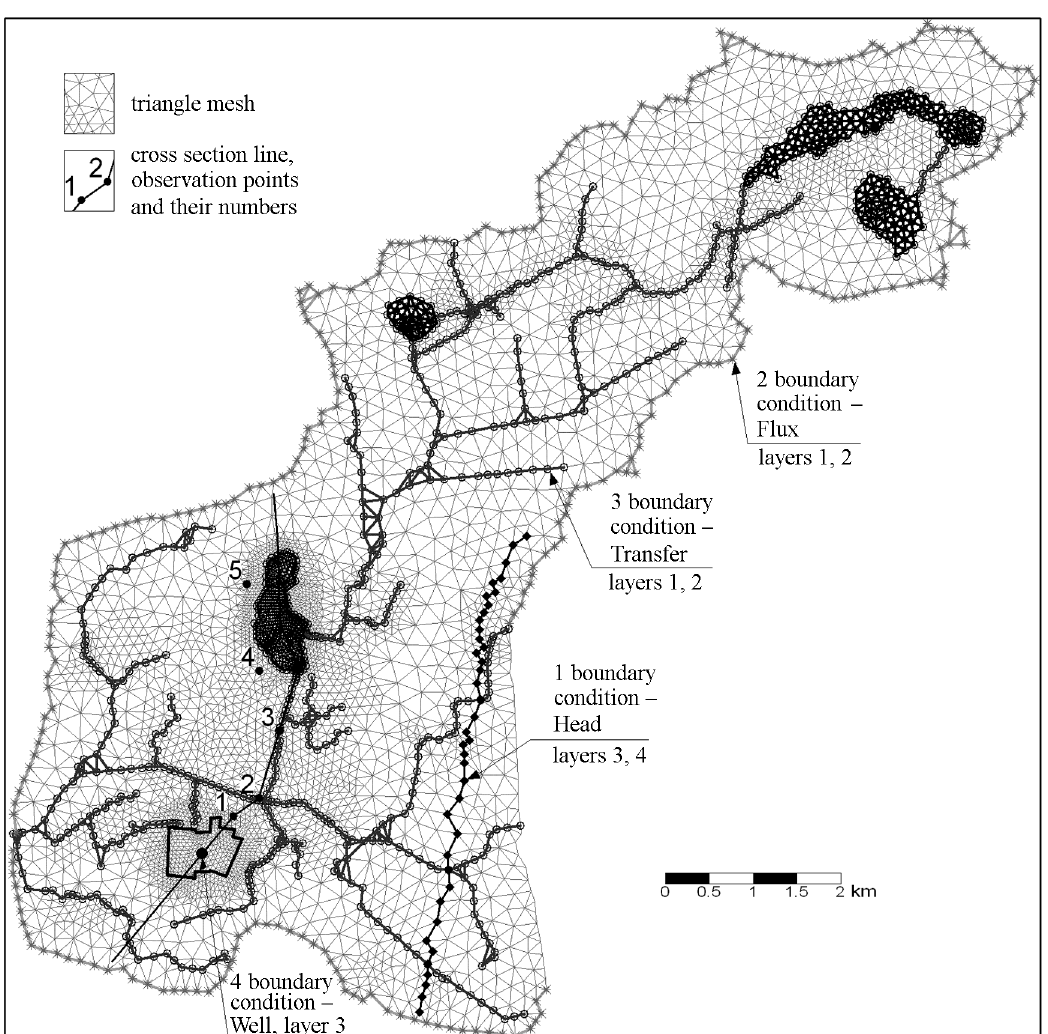
Fig. 4. Mesh geometry and boundary conditions for the FEFLOW finite element model of the Č edasai